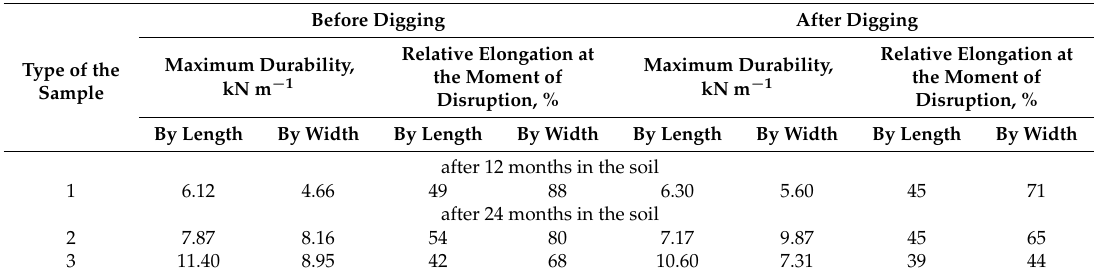
Table 4. A change of durability values of geotextile nonwoven